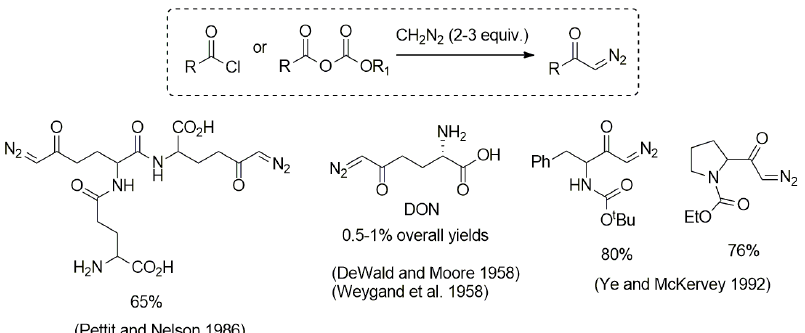
and some representative